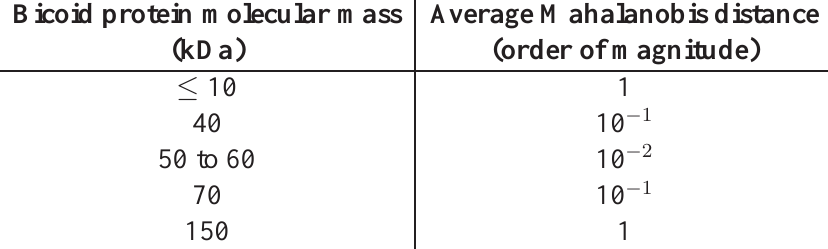
Table 1: Order of magnitude of the discrepancy between experiments of simulations performed with five nominal molecular mass of Bicoid protein. The best agreement has been achieved for a molecular mass in the range from 50 to 60